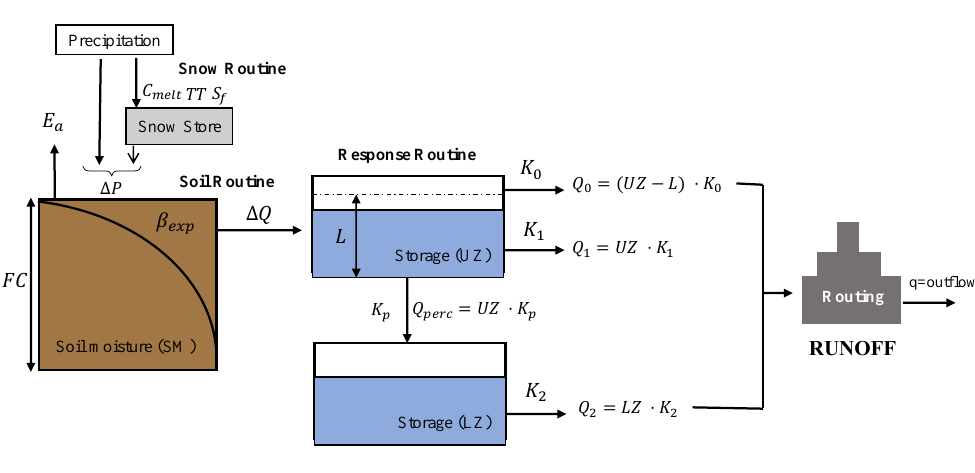
Figure 5. Conceptual diagram of the HBV